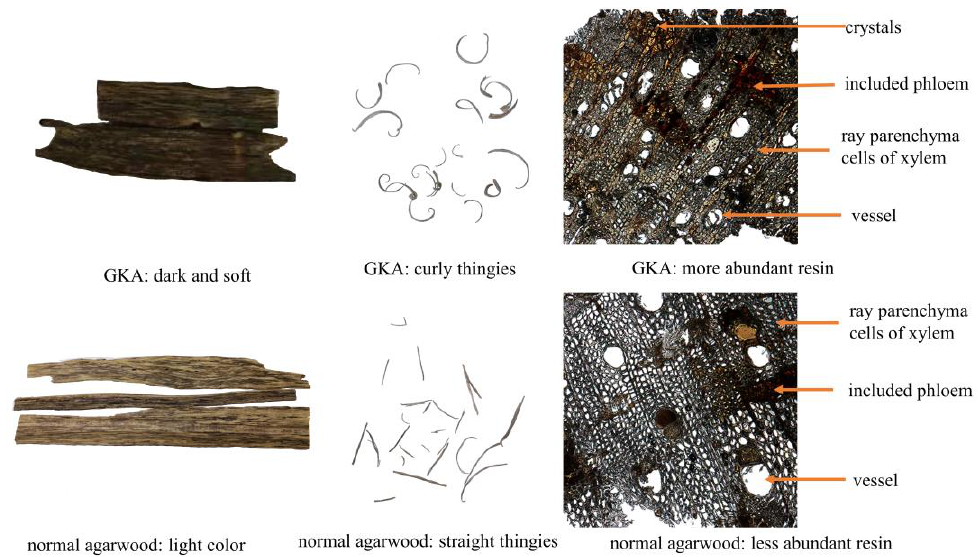
Figure 1. Morphology of the samples of two representative types of agarwood as well as their transverse section microscopic features (magnification of 100 × ) and wood flake morphology.